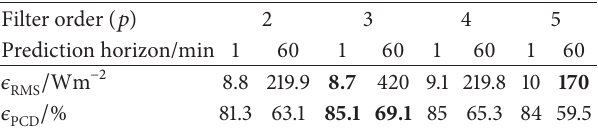
Table 6: Solar radiation prediction results for a five- state MARM. Filter order 𝑝 2 3 4 5 Prediction horizon/min 1